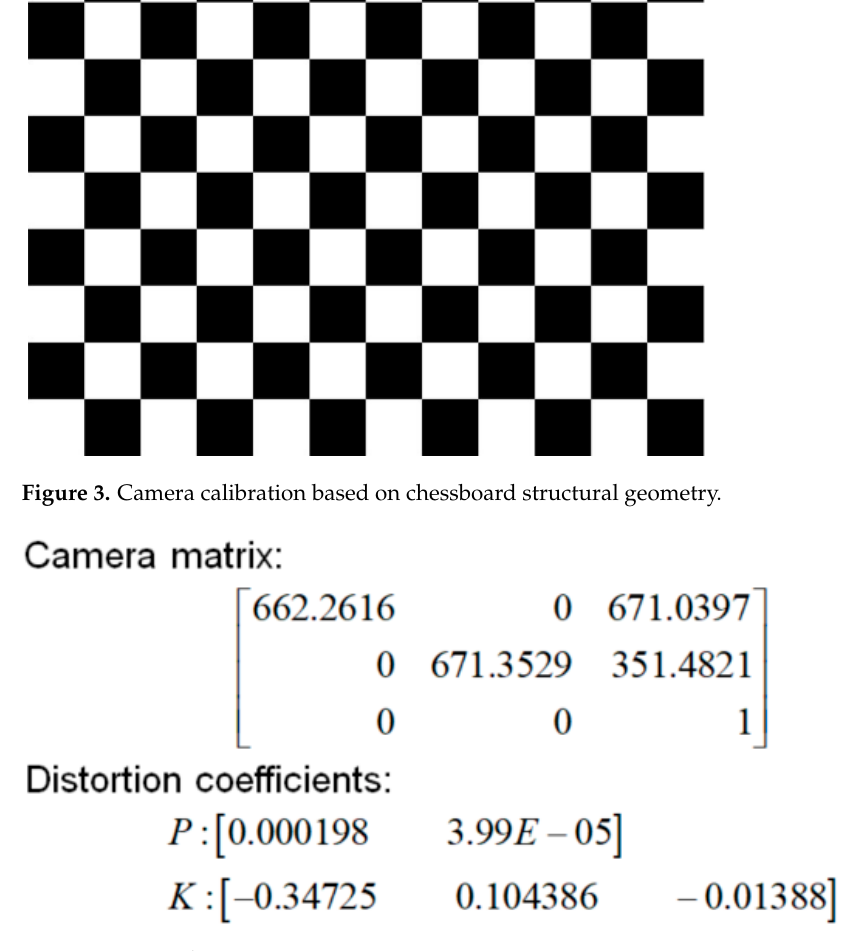
Figure 4. Internal camera parameter matrix.